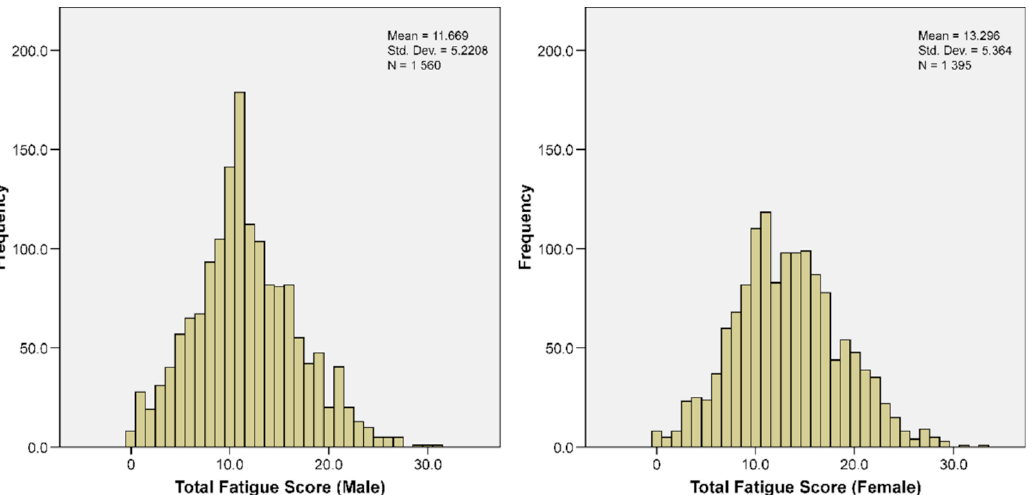
Figure 2. Distribution of the fatigue score for male participants ( left ) and female participants ( right ).